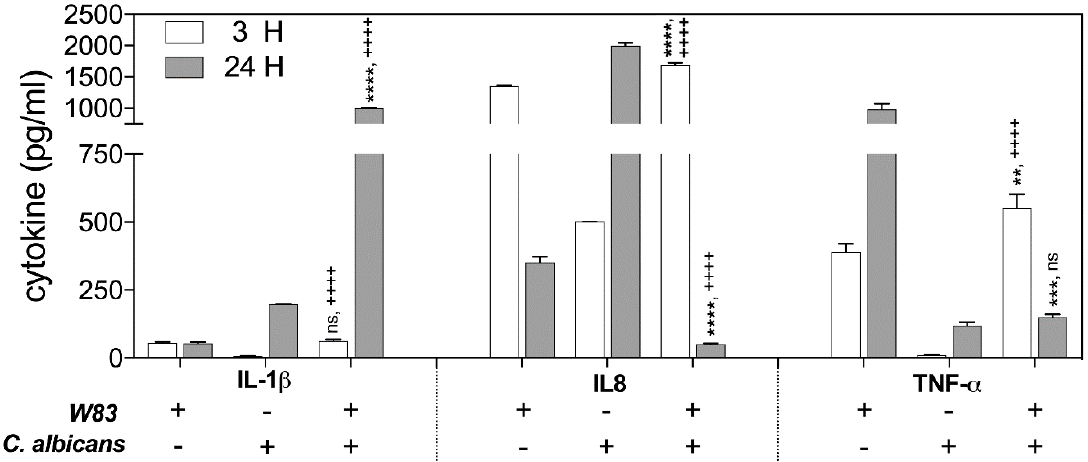
Figure 1. Changes in the protein production of the indicated cytokines in monocyte-like THP-1 cells under contact with supernatants acquired from biofilms formed by fungal ( C. albicans ) and bacterial ( P. gingivalis ) pathogens. THP-1 monocyte-derived macrophages were incubated with supernatants obtained from a mixed-species biofilm formed for 3 and 24 h by P. gingivalis and C. albicans cells (MOI = 100:1) or from a single-species biofilm of these microbes. The protein production level was analyzed by ELISA. The signal from appropriate references, where the THP-1 cells were treated with the fresh medium, was subtracted from the values measured for cells treated with supernatants. The experiment was performed in triplicate in three independent repetitions. The data from a representative repetition are expressed as the mean ± SEM. One-way ANOVA with a Bonferroni’s multiple comparisons test was used to determine the statistical significance levels for comparisons of mixed biofilm versus bacteria or fungi and marked with (*) or ( + ), respectively. Number of asterisks or crosses denote statistical significance ( p > 0.1234 ns, ** p ≤ 0.0021, *** p ≤ 0.0002, **** p < 0.0001).